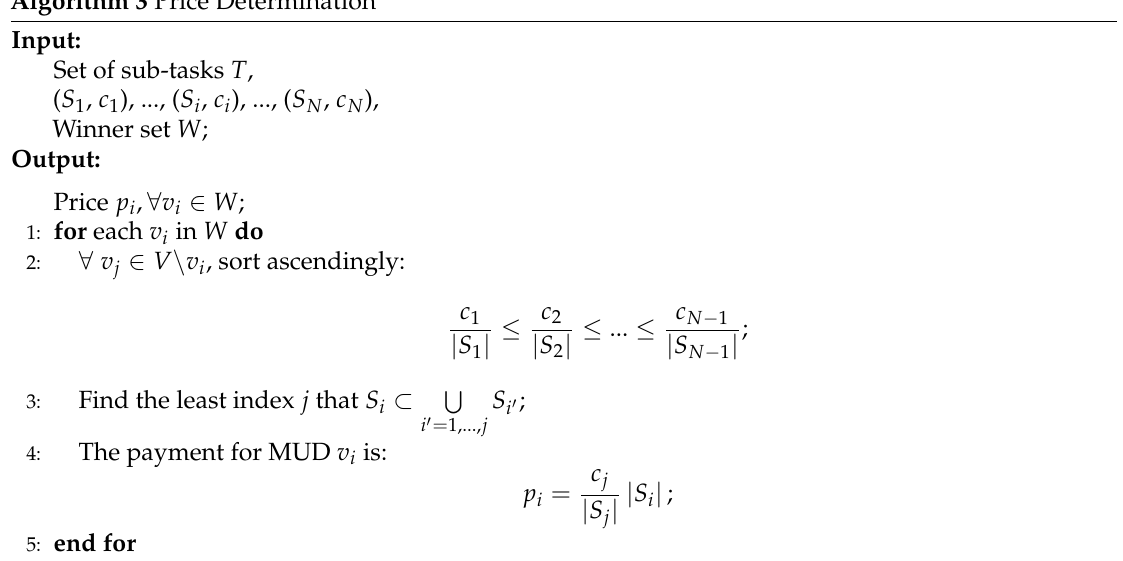
Algorithm 3 Price